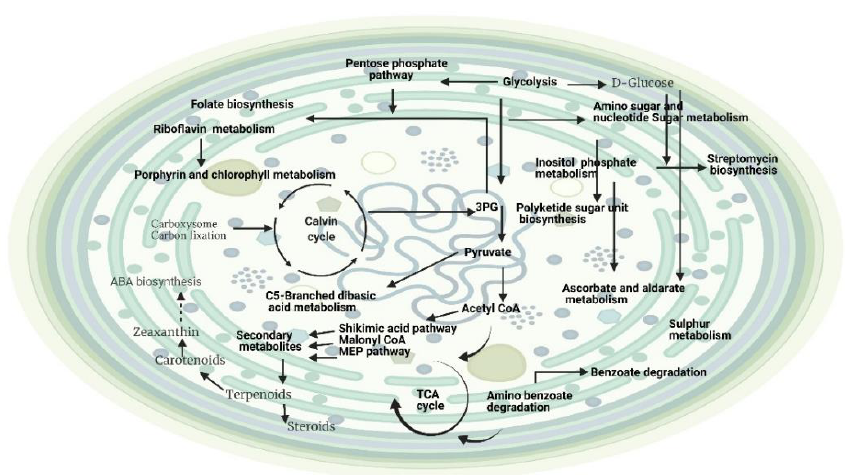
Figure 2. Cellular model representing the effects of light on the metabolic activities of Planktothricoides sp. (SR001) based on metabolic profiling. The metabolites corresponding to pathways shown in the grey color were partially identified. Created with BioRender.com (accessed on 4 August 2021).